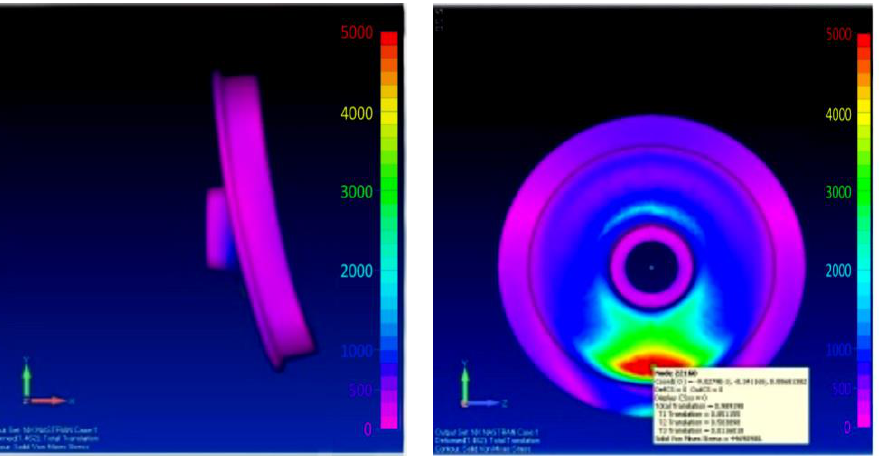
Figure 9. Force disbalance and deformation of the tread surface from bending stresses. The first force disturbances were transmitted to the axle at the base of the wheel. This is also evidenced by the red colour of the spectrum (Figure 8b).